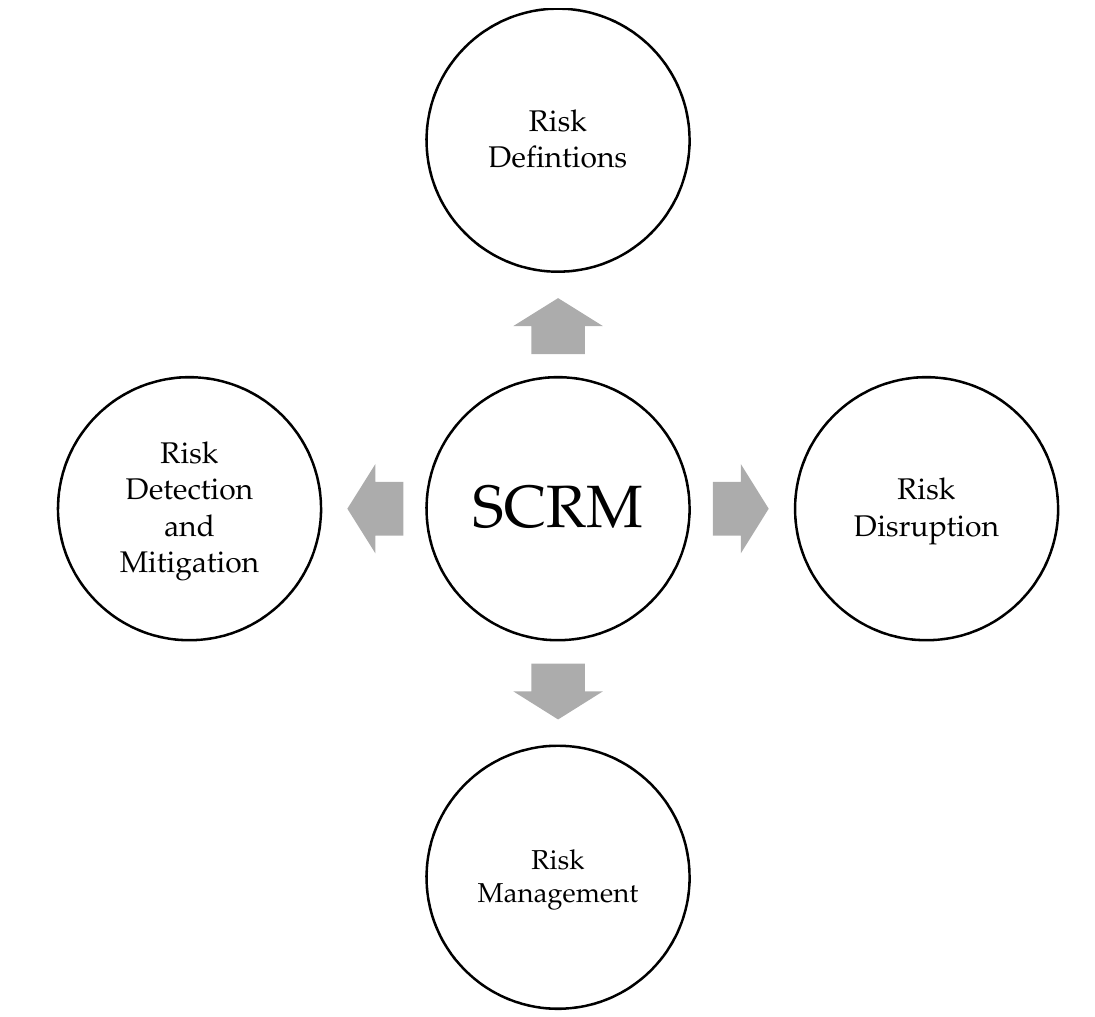
Figure 1. Supply chain risk management (SCRM) categories.